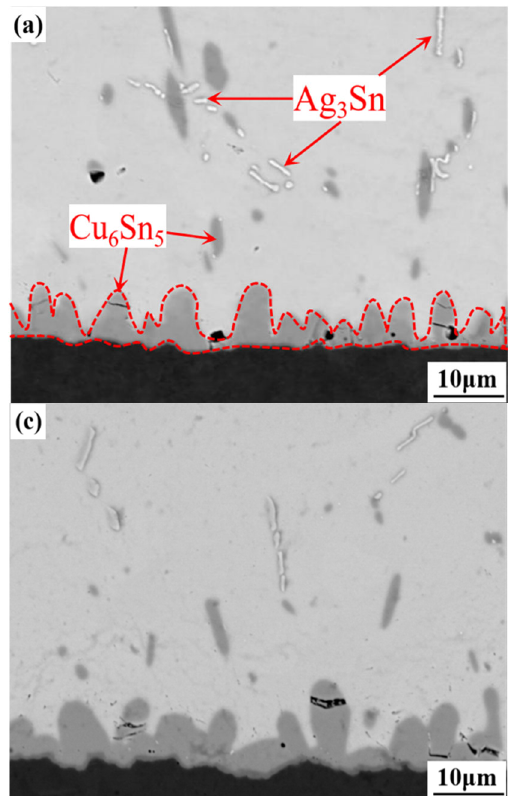
Figure 3. Microstructure images of SAC105/Cu: ( a – c ) and SAC105 ‐ (nano)Al 2 O 3 /Cu: ( d – f ) subjected to 100 cycle: ( a , d ); 400 cycle: ( b , e ); 1000 cycle: ( c , f ).